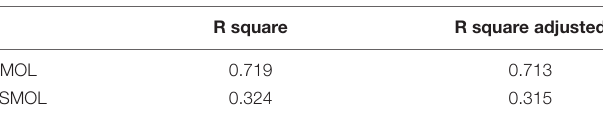
TABLE 7 | Assessment of R 2